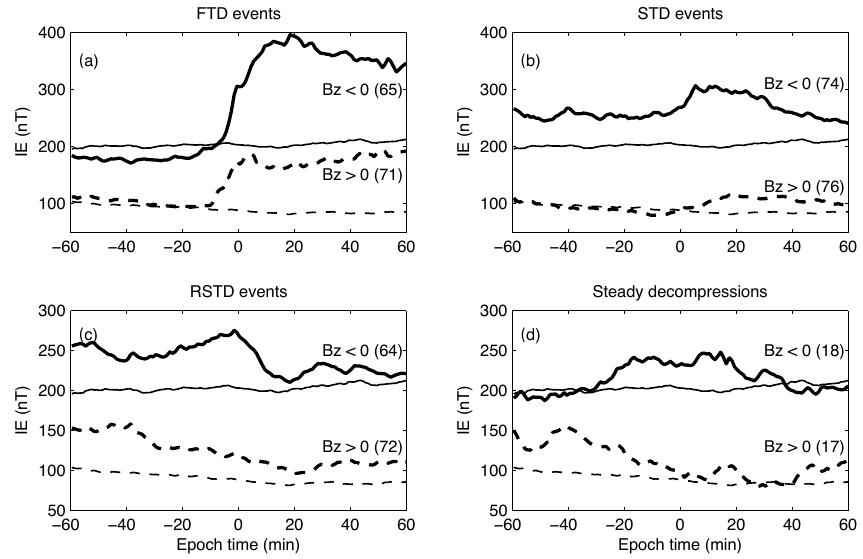
Fig. 5. Ionospheric response according to the average IMF direction 30min prior to the event. Solid (dashed) lines show events for which the IMF has been southward (northward) for 30min prior the epoch zero. Thin solid and thin dashed lines are the random events grouped similarly according to the IMF direction. Superposed epoch averages for the IE index for (a) FTD (b) STD, (c) RSTD and (d) steady decompressions are shown. Numbers in parentheses near each line show the amount of events in each category.